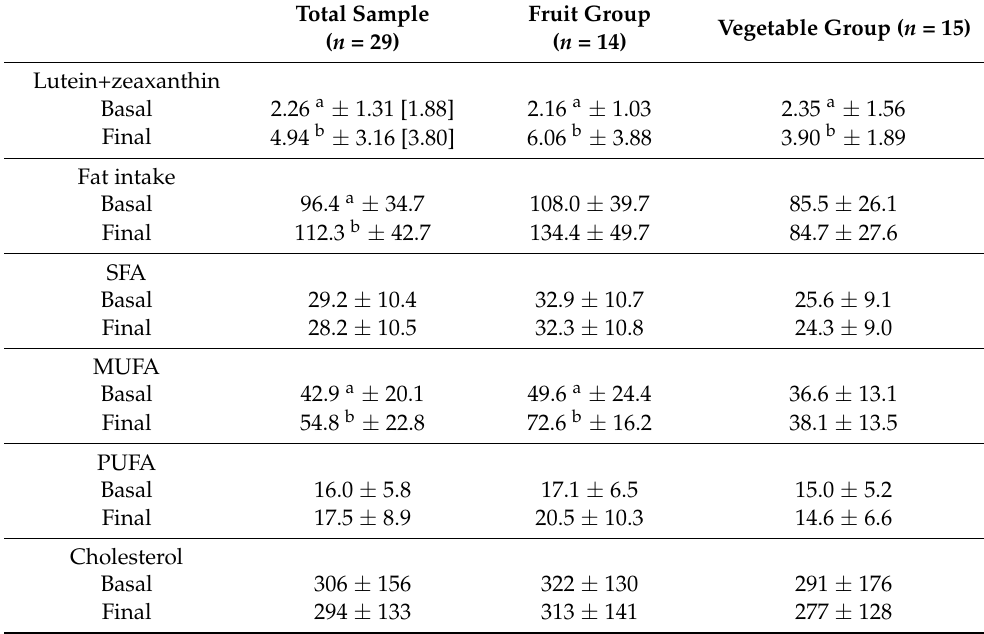
Table 3. Lutein and zeaxanthin ( µ mol/day), fat, SFA, MUFA, PUFA and cholesterol (g/day) total dietary intake expressed as mean ± SD